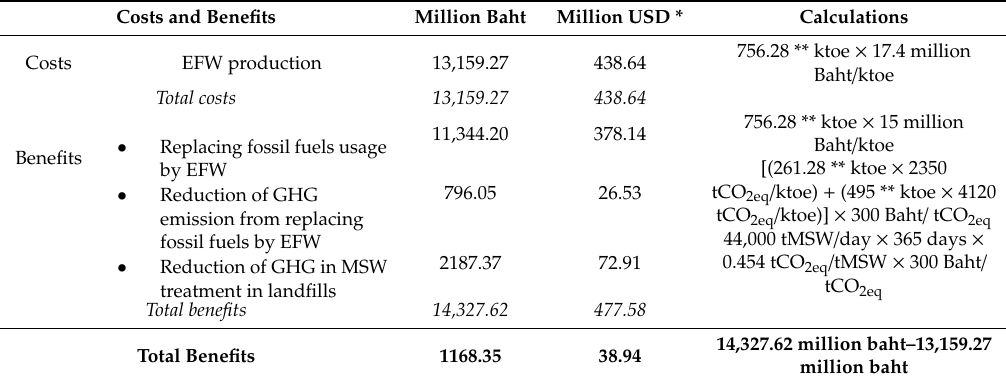
Table 7. Costs and benefits of achieving energy-from-waste (EFW) targets in